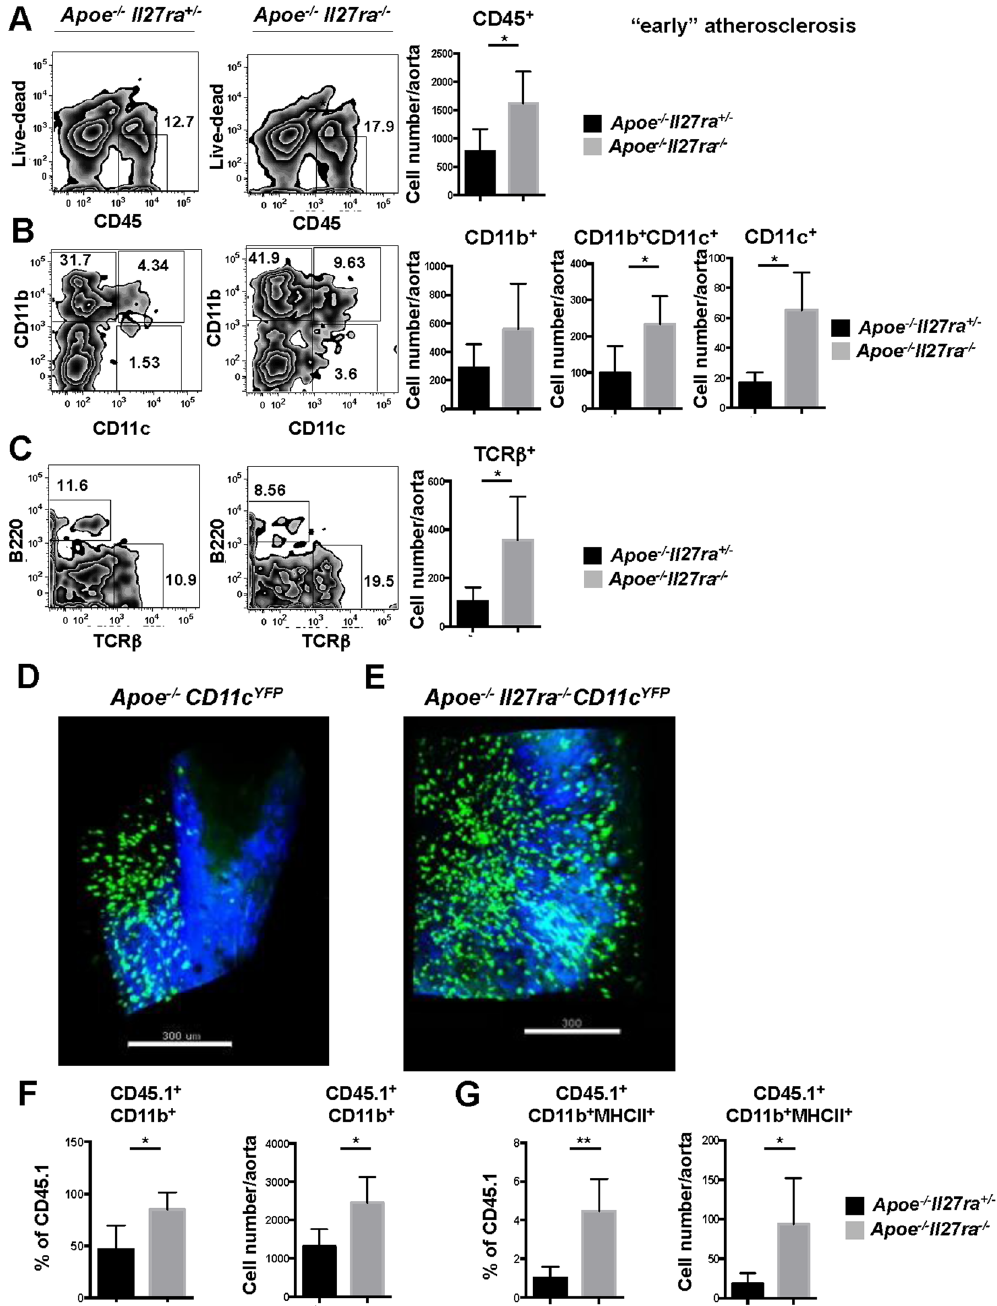
Figure 3. Enhanced accumulation of immune cells in aortas of Apoe − / − Il27ra − / − mice. Live CD45 + cells from aortas of Apoe − / − Il27ra + / − or Apoe − / − Il27ra − / − mice fed with WD for 7 weeks were stained for CD45 + , CD11b + , CD11c + and TCR β + . Percentage ( left ) and cell number ( right ) ( A–C ) of live CD45 + , CD11b + CD11c − , CD11b + CD11c + and CD11b- CD11c + cells, TCR β + T cells in aortas of Apoe − / − Il27ra + / − or Apoe − / − Il27ra − / − mice fed with WD for 7 weeks was quantified by flow cytometry. Data are mean ± SEM from at least 3 independent experiments. Accumulation of CD11c YFP + APC in aortas of Apoe − / − ( D ) and Apoe − / − Il27ra − / − ( E ) mice was analyzed by 2 photon microscopy. Green – CD11c YFP + APC cells, blue – collagen detected by second harmonics generation. CD45.1 + monocytes from B6 mice were adoptively transferred to Apoe − / − Il27ra + / − (n = 5) or Apoe − / − Il27ra − / − (n = 6) mice fed with WD for 7 weeks. Monocyte recruitment to the aortas was assessed by flow cytometry 48 hours after cell transfer. Percentage and absolute number of recruited monocytes ( F ) and MHCII expression by recruited CD45.1 CD11b + monocytes ( G ) in the aortic wall of Apoe − / − Il27ra − / − and Apoe − / − Il27ra + / − mice. Data are mean ± SEM from 2 independent